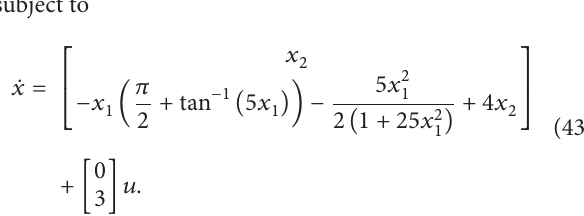
The optimum solution for this problem is 𝑢 ∗ (𝑥) = −3𝑥 2 and 𝑉 ∗ = 𝑥